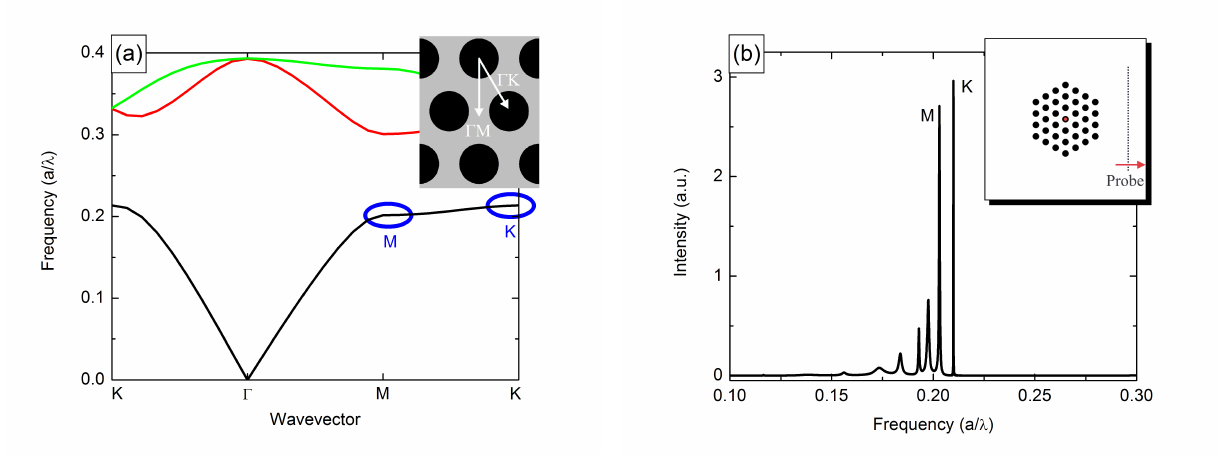
Figure 2. (a) Calculated bandstructure of the PhC for r/a = 0 . 3 and n MIT Photonic Bands package [39,41]. The full bandgaps for TM-polarized light are clearly visible. The designed lasing points are M and K in the lowest band. (b) Predicted modes using finite-difference time-domain calculations [40]. The two lasing modes show a quality factor of 10 3 . The inset shows a schematic of the computational cell; the source is positioned in the central pillar, the probe at the side of the